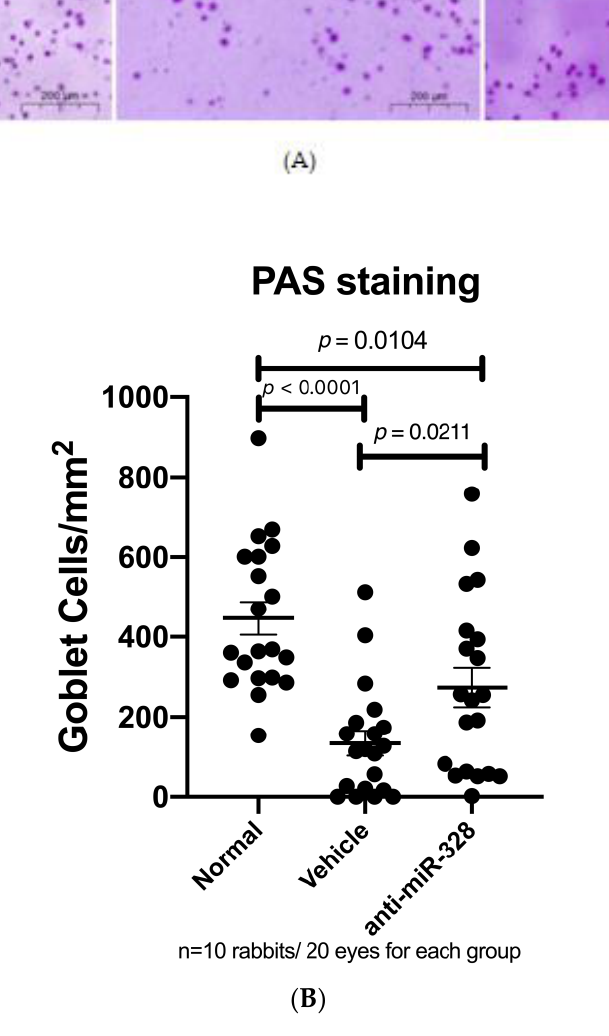
Figure 3. Anti-miR-328 treatment increases goblet cells. ( A ) Representative images of PAS staining, scale bar = 200µm. ( B ) PAS staining results show that anti-miR-328 treatment increased conjunctival goblets cells in BAC-induced DED rabbits. n = 10 rabbits/20 eyes for each group.